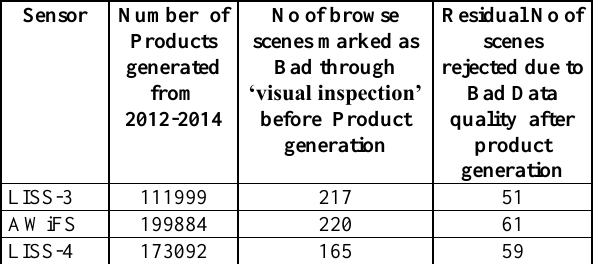
Table 1. Number of products rejected for Resourcesat-2 during 2012-2014. Many products were rejected after manual screening